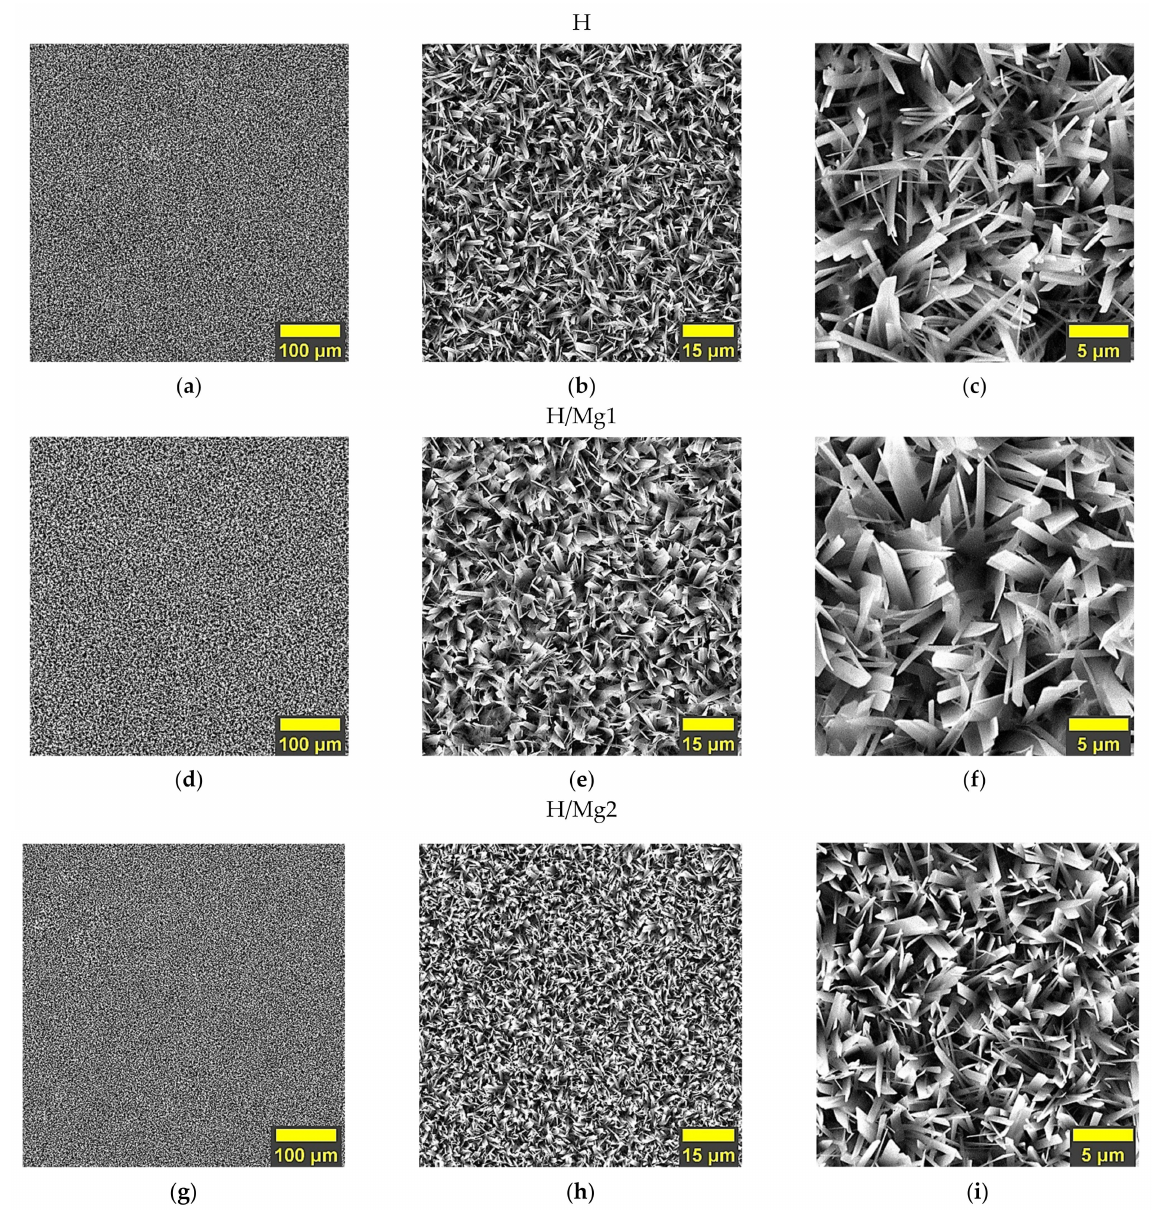
Figure 2. Morphology of the H ( a – c ); H/Mg1 ( d – f ); and H/Mg2 ( g – i ) coatings deposited on the nanostructured surfaces (see Figure S2 in Supplementary File for the original SEM